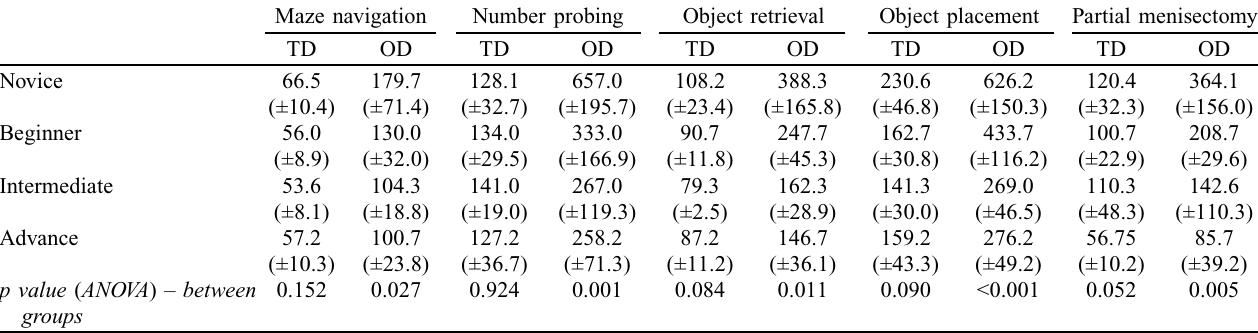
Table 3. Mean times (± SD ) for completion of task for different sub-groups under transparent dome (TD) and opaque (OD) domes. Maze navigation Number probing